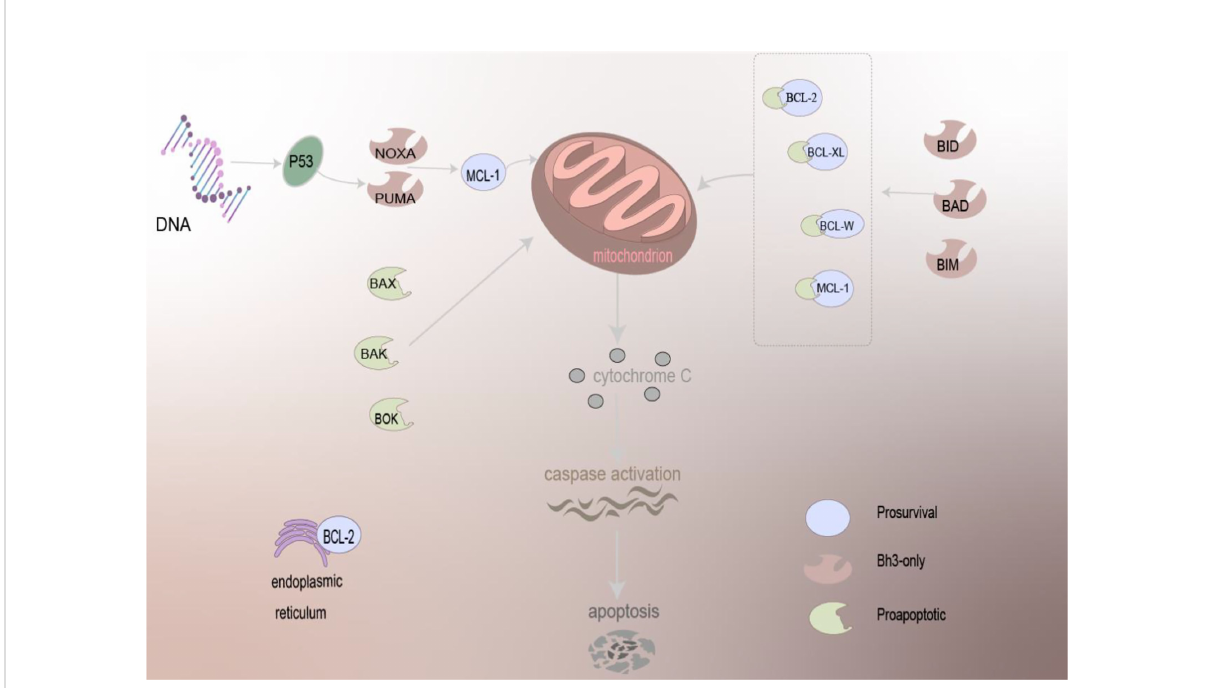
FIGURE 1 The mechanism of BCL-2 family proteins in regulating apoptosis. Driven by BCL-2 family proteins, which are primarily localized to mitochondria and present on the ER, pro-apoptotic family proteins can act directly on the mitochondria to trigger the apoptosis mechanism, and anti- apoptotic proteins need to work together with other proteins to cause apoptosis, release cytochrome C, and activation of caspase of